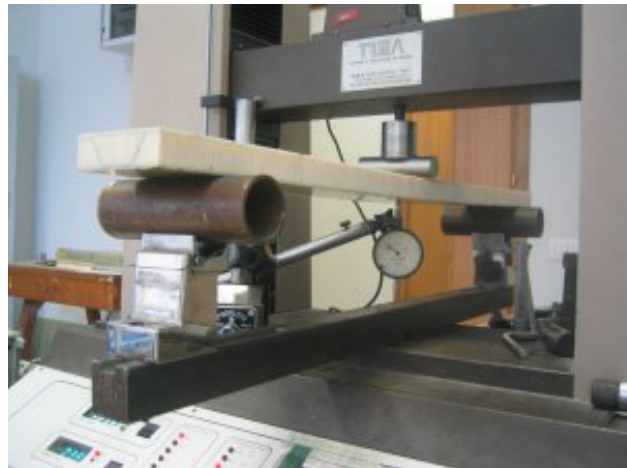
Figure 6: Experimental setup for the TPB tests.